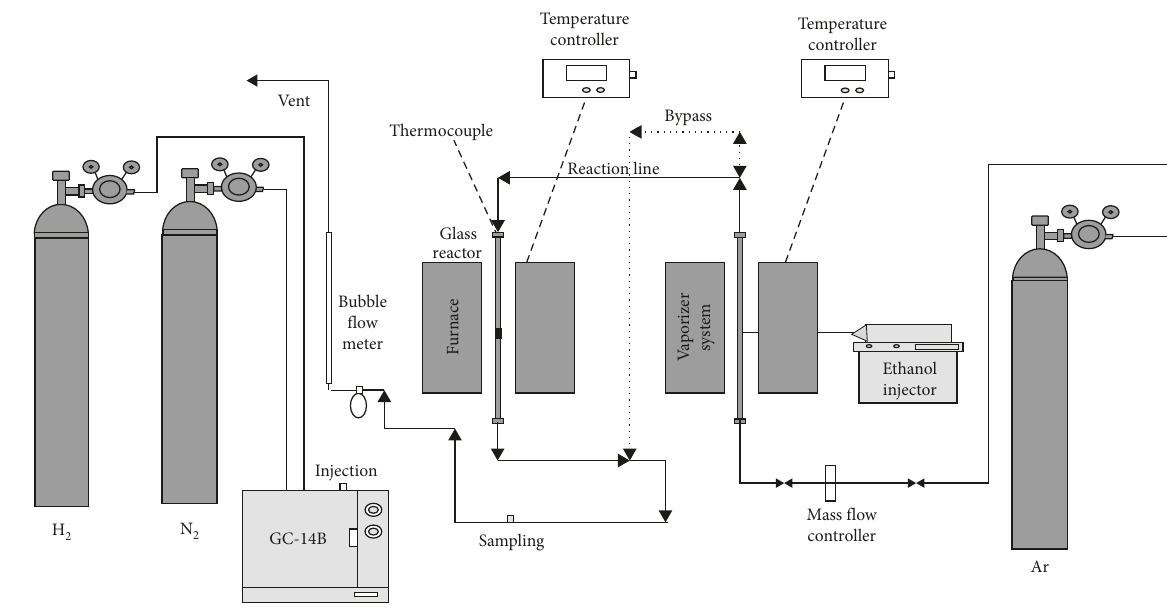
Scheme 2: Ethanol dehydration system.